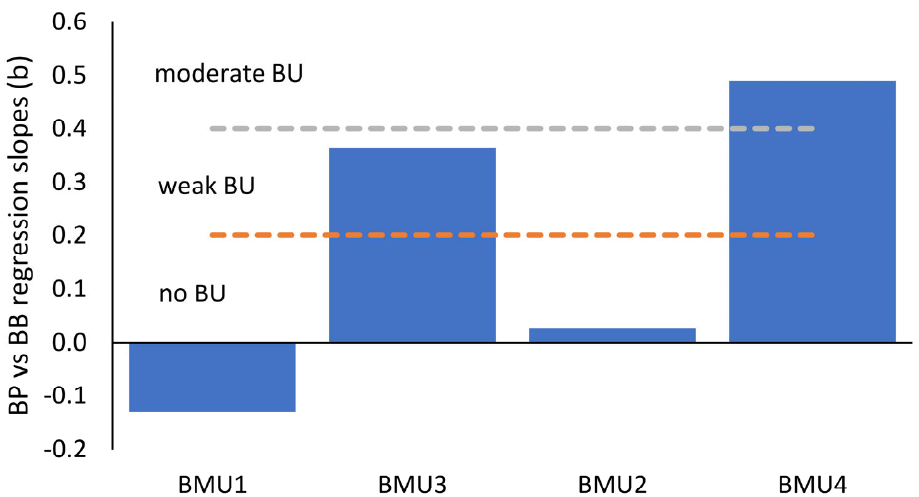
Figure 4. Regression slopes of bacterial production (BP) vs. bacterial biomass (BB) representing the relative BU and TD control of bacterial population for analysed clusters. The orange line marks the upper limit of no BU, and the grey line marks the upper limit for weak BU values according to Ducklow [59]. Values are standardized as z-scores.